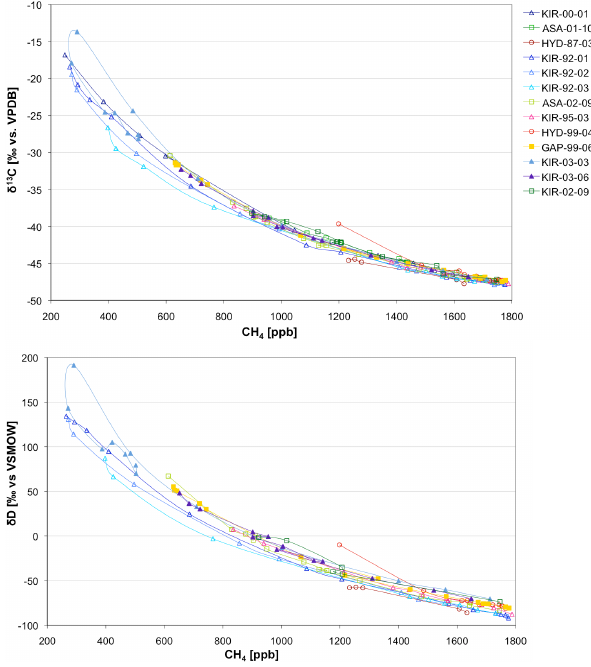
Figure 2: Isotope:tracer relations δ (c) for the balloon data shown in Fig. 1. 805 Fig. 2. Isotope:tracer relations δ(c) for the balloon data shown in Fig.